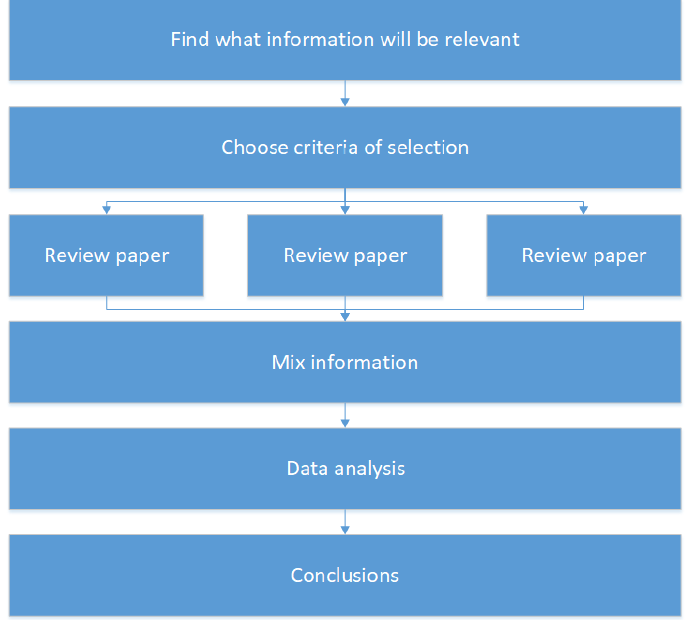
Figure 2. Method followed to do the